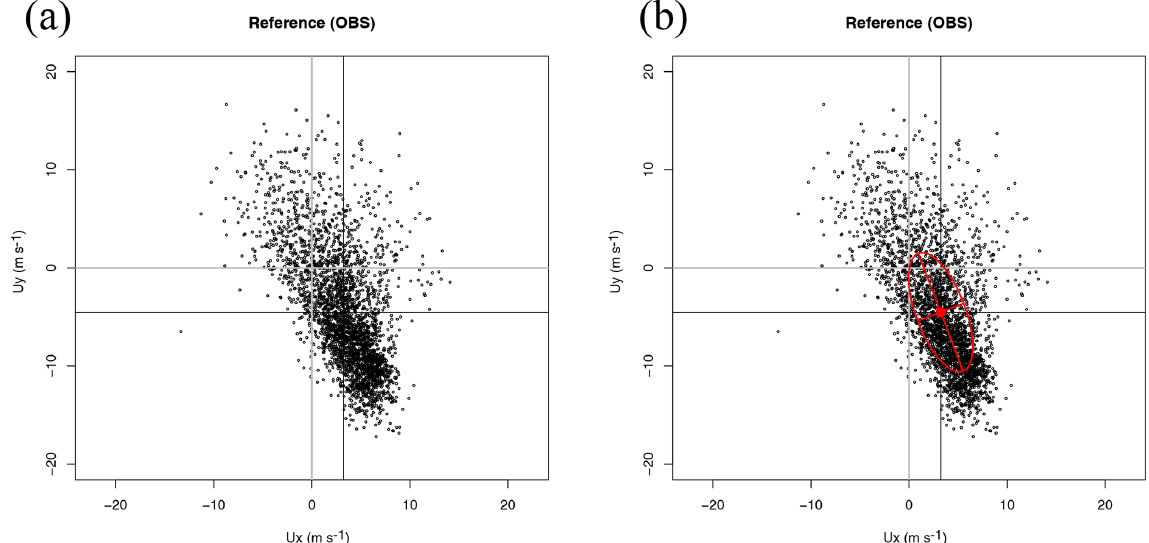
Figure 1. Scatterplot of wind in dataset Ref (a) and its decomposition in terms of the principal axes corresponding to the covariance matrix of the zonal and meridional components (b) as defined in Eq.